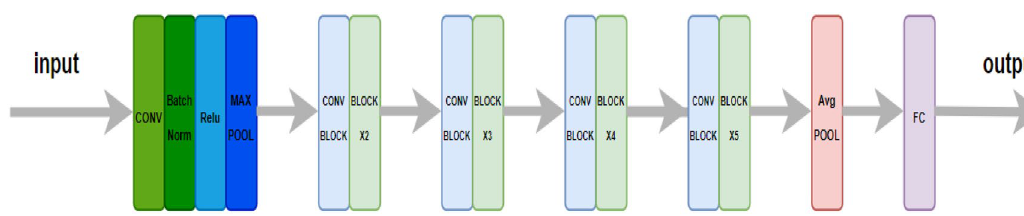
Figure 2. Schematic diagram of Resnet50 network